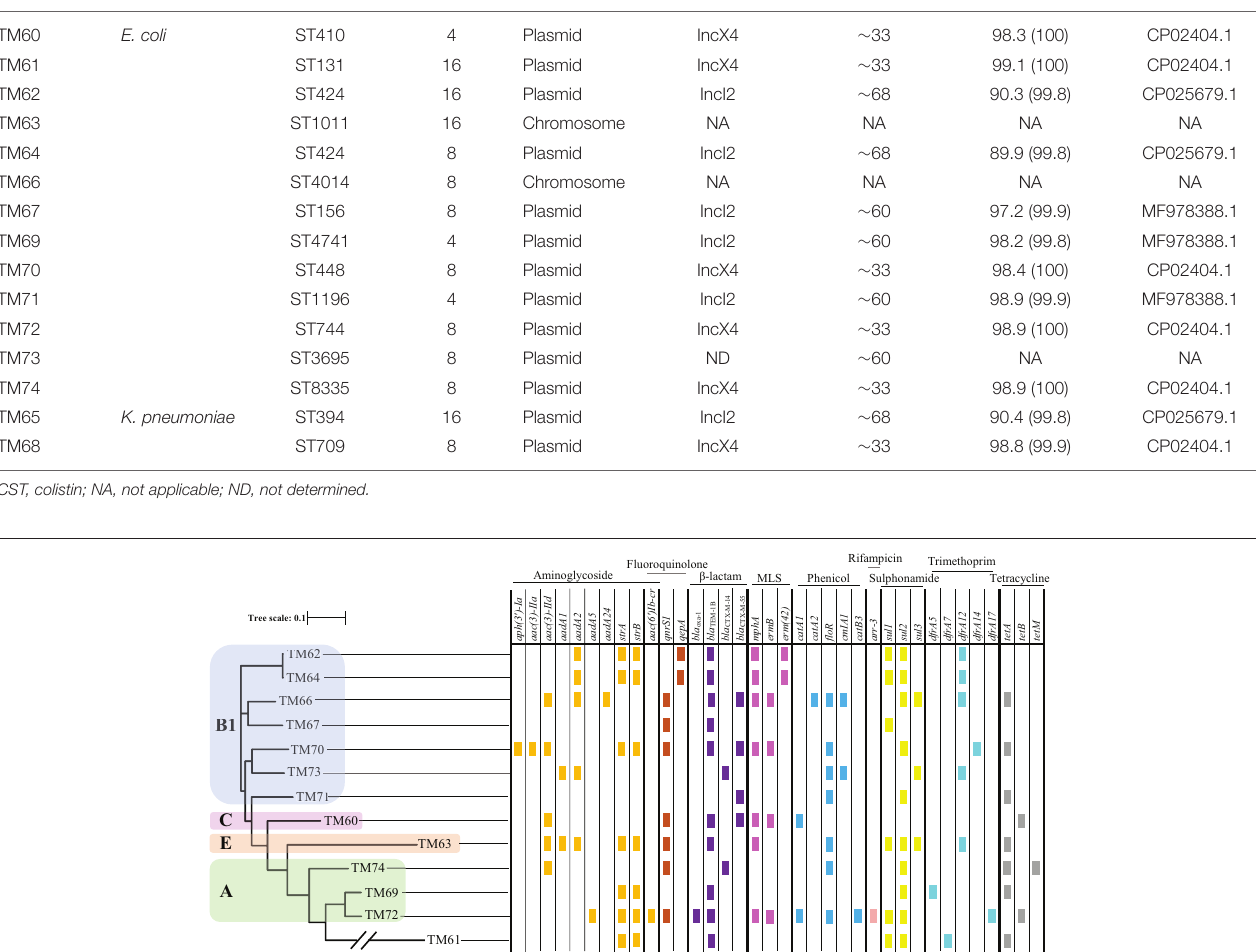
of IncI2 plasmids identified in other MCRPEn isolates in